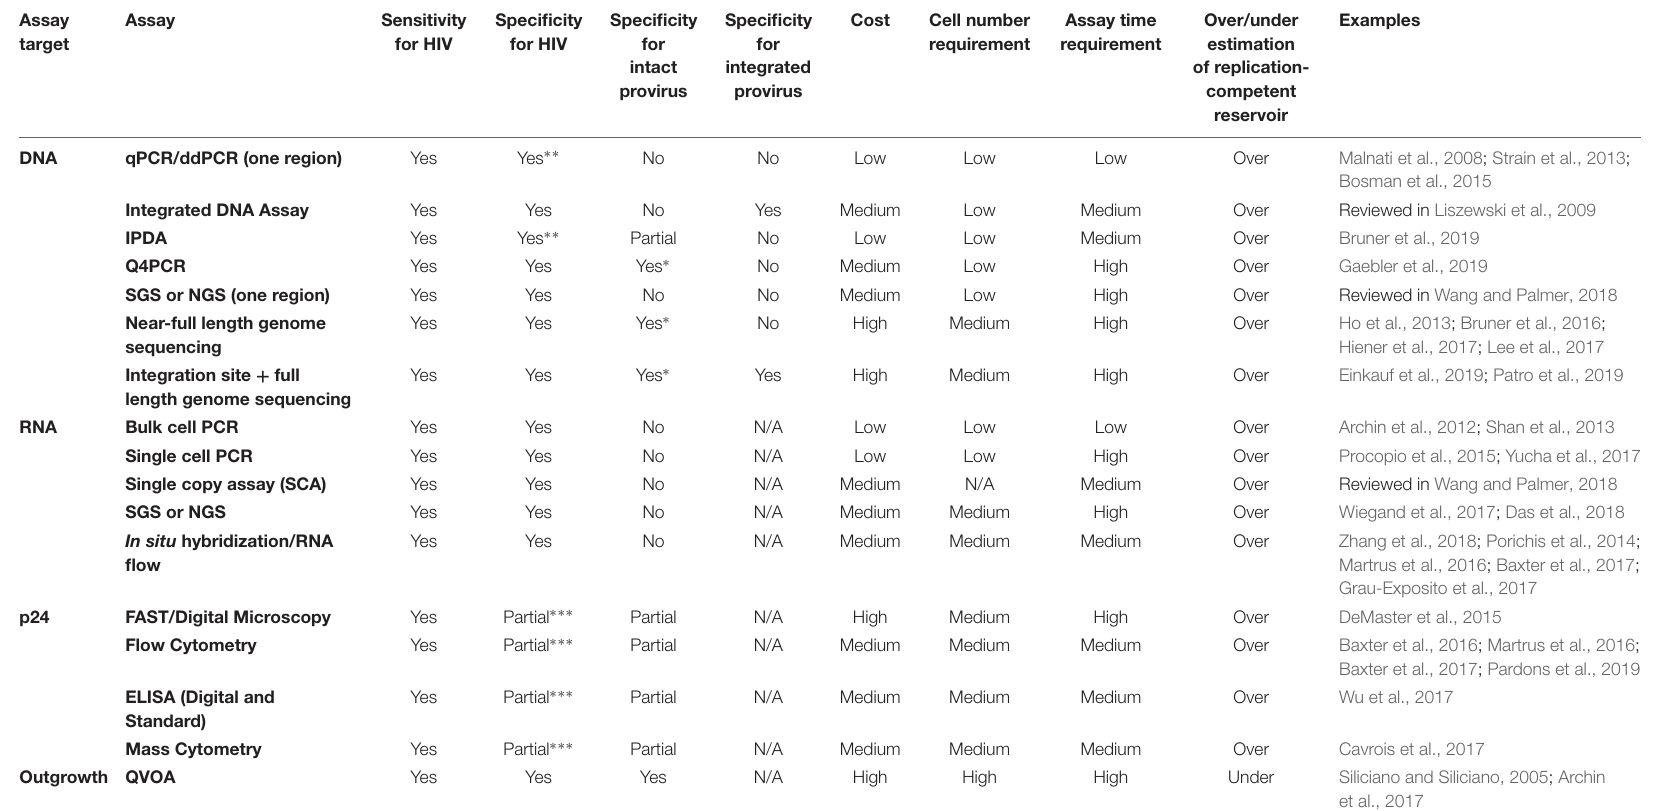
TABLE 1 | Overview of reservoir assays. Assay target